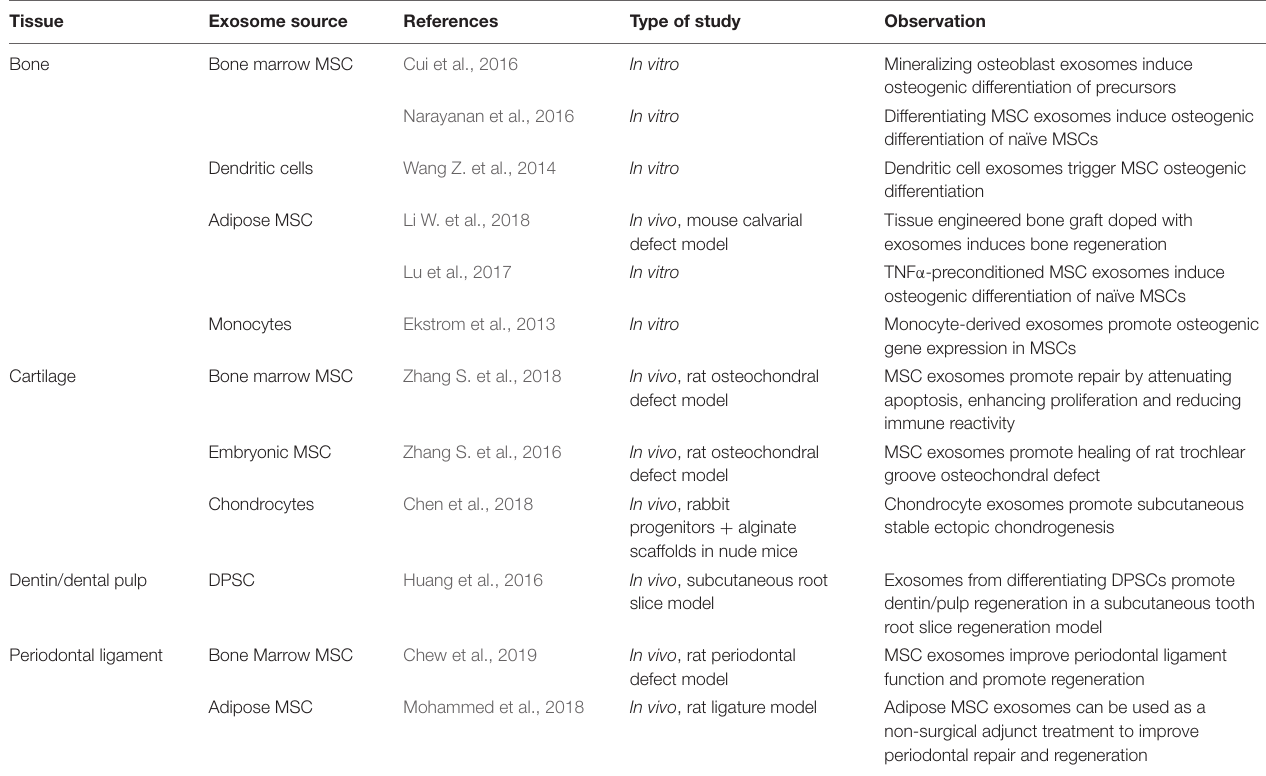
TABLE 1 | MSC exosomes in craniofacial repair and